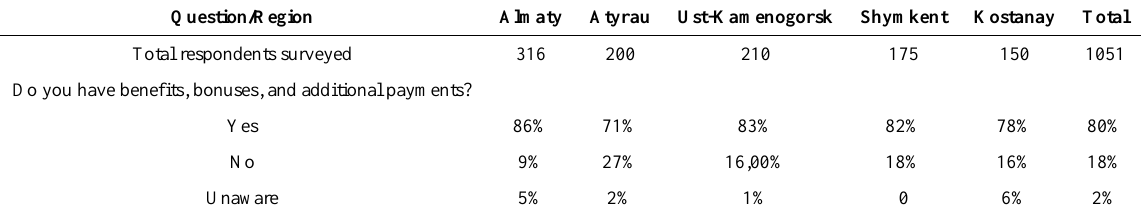
Table 1. Data on healthcare workers who have got/receive bonuses and benefits to the basic pay rate